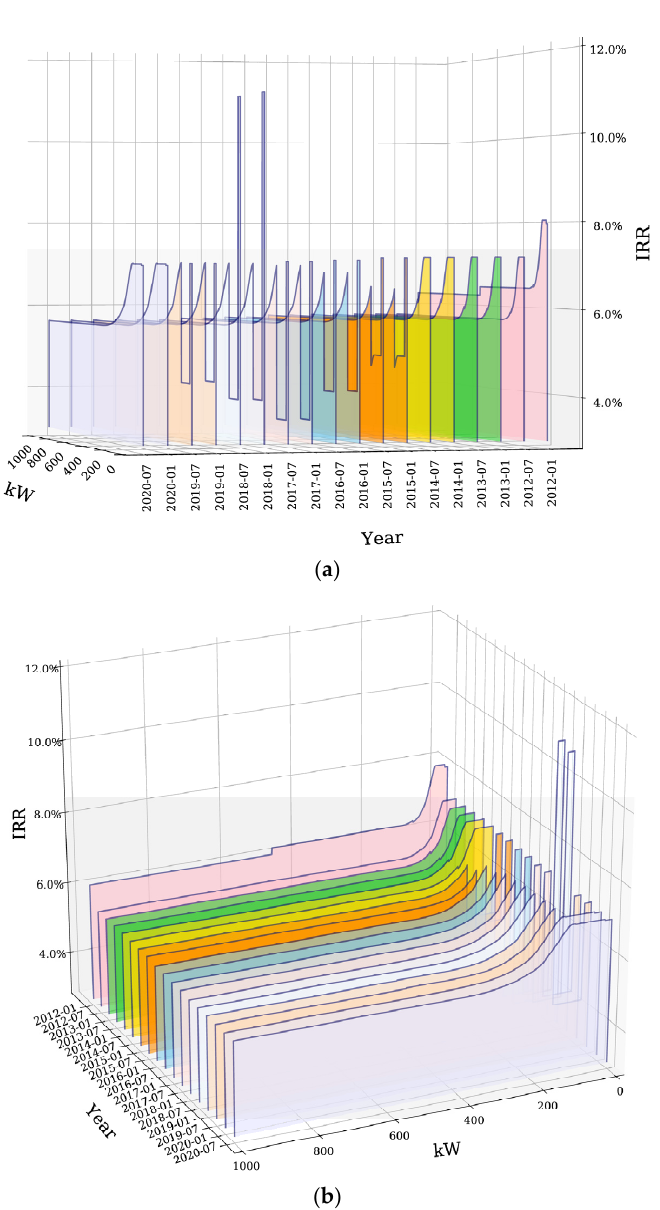
Figure 5. Equity IRRs (Internal Rate of Returns) for rooftop PVS with capacity 1 to 1000 kW, from different angles ( a , b ) (2012–2020) Source: